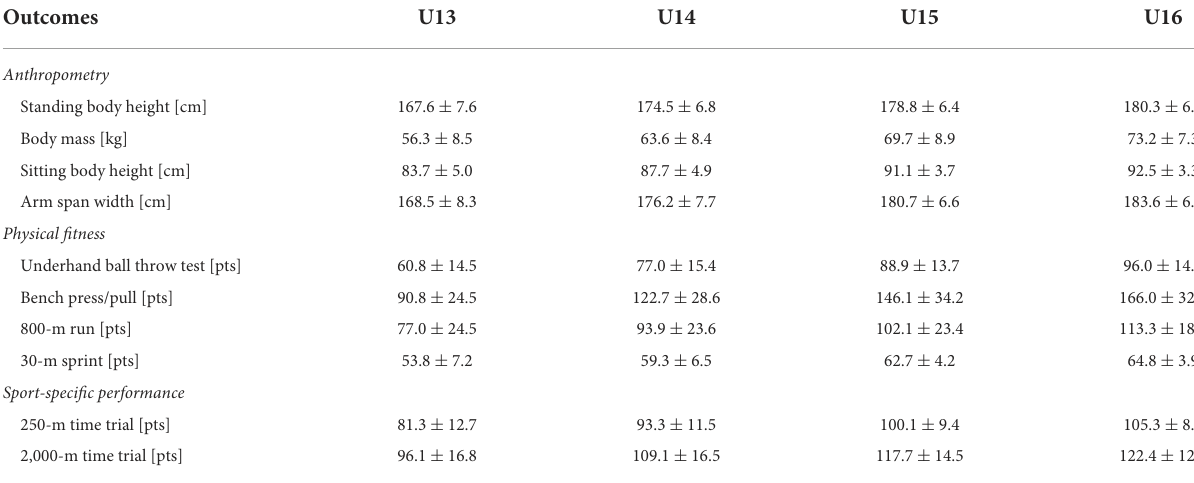
TABLE 2 Anthropometric, physical fitness and sport-specific performances measures in young male kayakers.